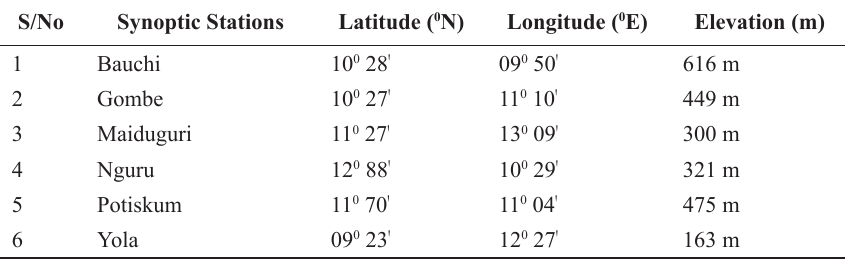
Table 1: Locations of the Six Synoptic Stations in the study